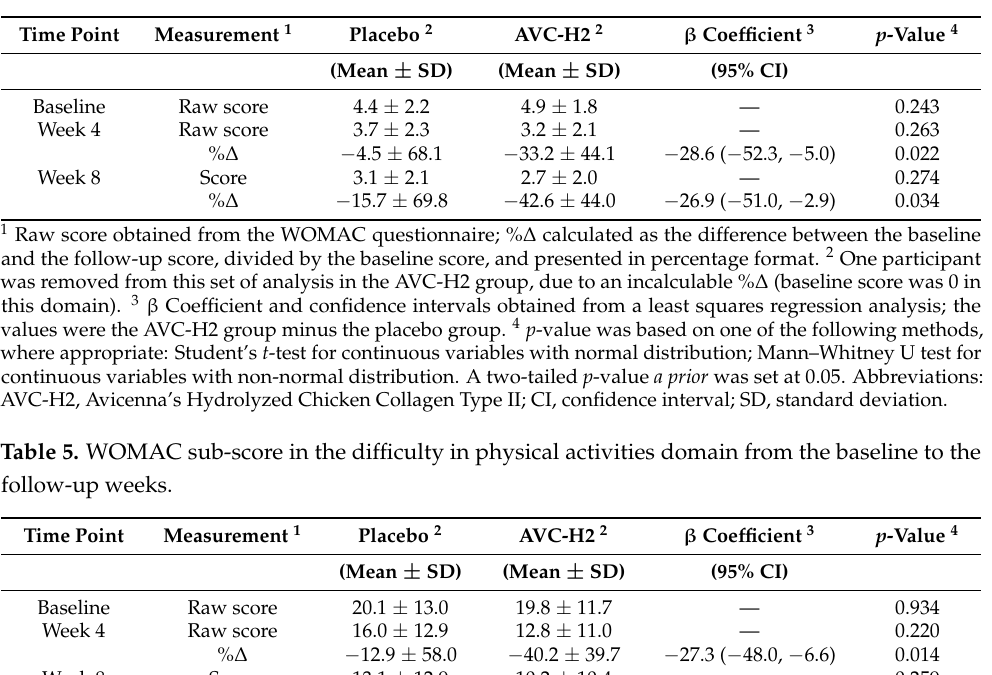
Table 4. WOMAC sub-score in the stiffness domain from the baseline to the follow-up weeks.